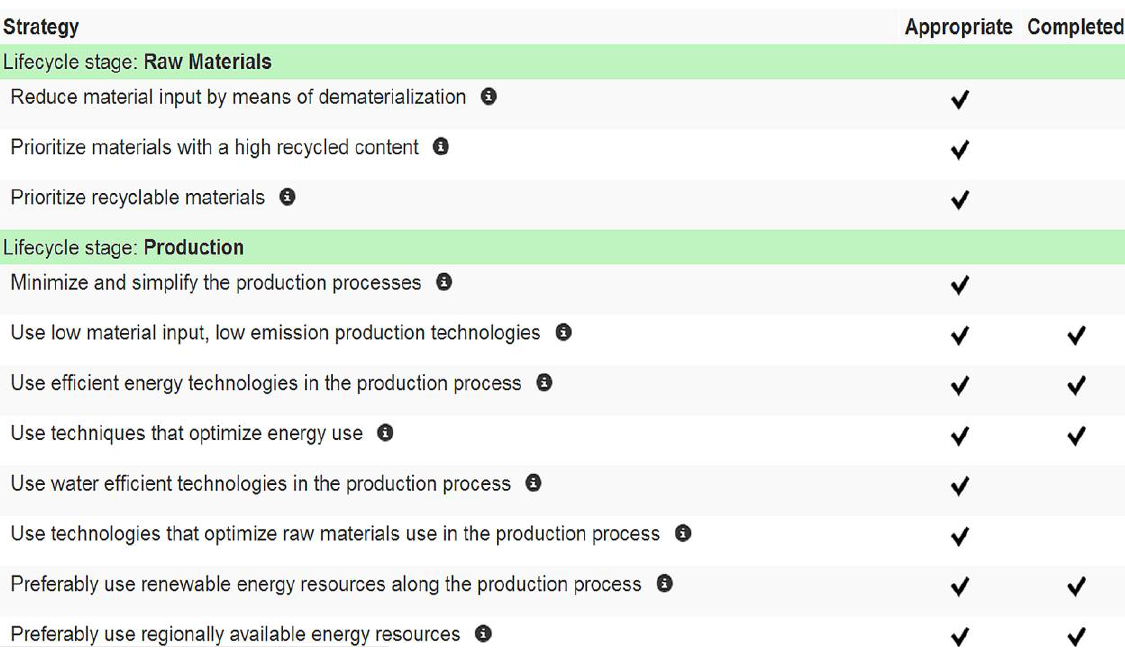
Figure 5. List of potential ecodesign strategies, which are presented based on the critical life cycle stages previously identified.